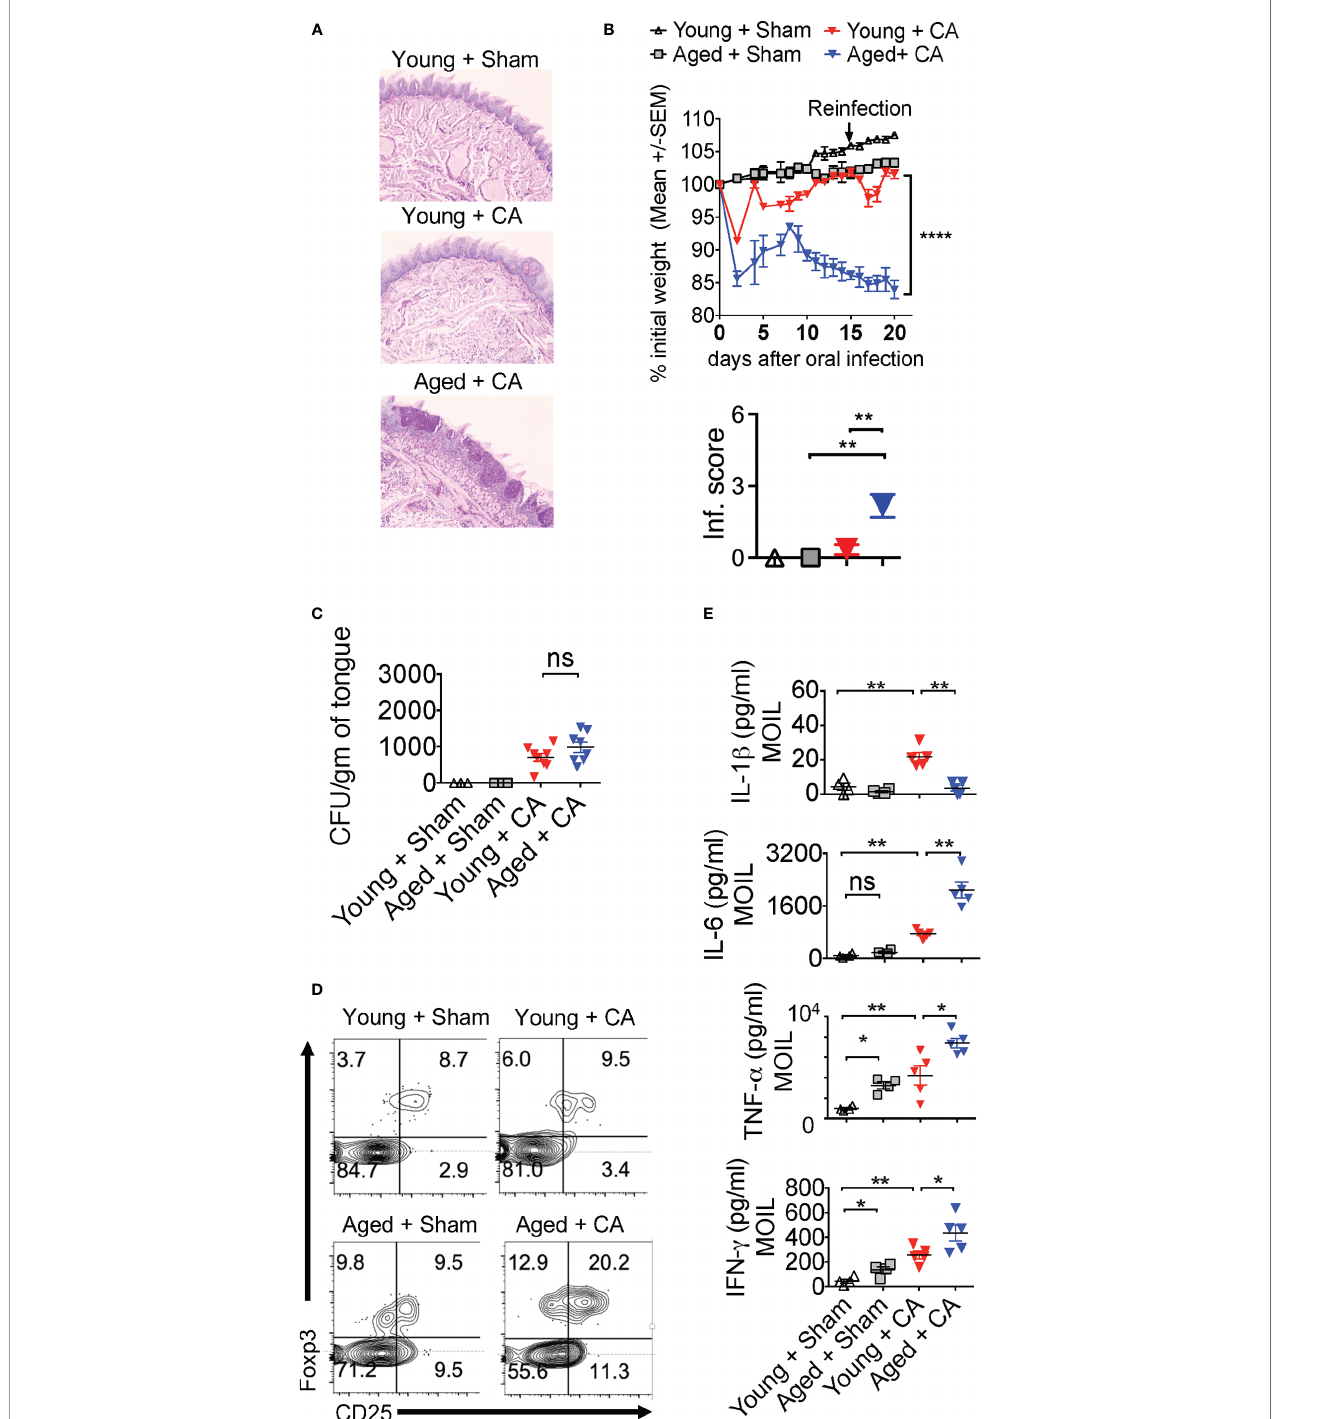
FIGURE 8 | Aged mice show diminished IL-1 b but excessive IL-6 expression and immunopathology during OPC. Young (6 weeks) and Aged (age 12 – 18 months) mice were sublingually infected and re-infected with CA or Sham (n= 4 – 5/group) as in Figures 2 and 3 . Histological analyses of PAS staining (A) , body weight ( B above), tongue in fl ammation score ( B , below) and fungal burden in tongue lysates (C) on day 7 of infection are shown. (D) Flow cytometric analyses of oral mucosal CD3 + CD4 + gated cells for CD25 and Foxp3; Geometric means of CD25 in Foxp3+ cells: Young + Sham= 776; Young +CA= 851; Aged + Sham= 334; Aged + CA=618. (E) Supernatants were collected from MOIL cells restimulated with PMA/Ionomycin, and IL-1 b (on day 2 after infection), and IFN- g , IL-6, and TNF- a levels (day 5 after infection) were quanti fi ed by ELISA. NS, non-signi fi cant. *P < 0.005, **P < 0.0005, ****P <